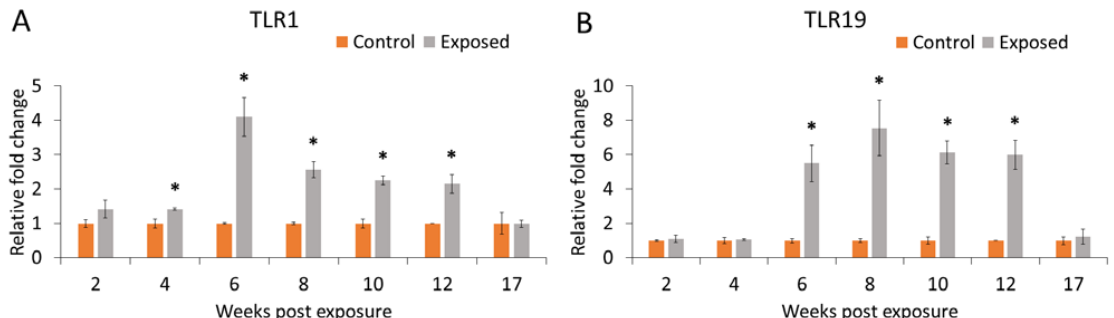
Figure 6. Relative expression of TLR1 and TLR19 in the posterior kidney of brown trout. ( A ) Expression profile of TLR1 that attained a peak at 6 wpe. ( B ) Expression profile of TLR19, which had a peak expression at 8 wpe. Significant differences in the mRNA expression of each gene between the exposed and control groups at each time points are indicated with an * ( p < 0.05). Each bar shows the mean ± SEM ( n = 9).